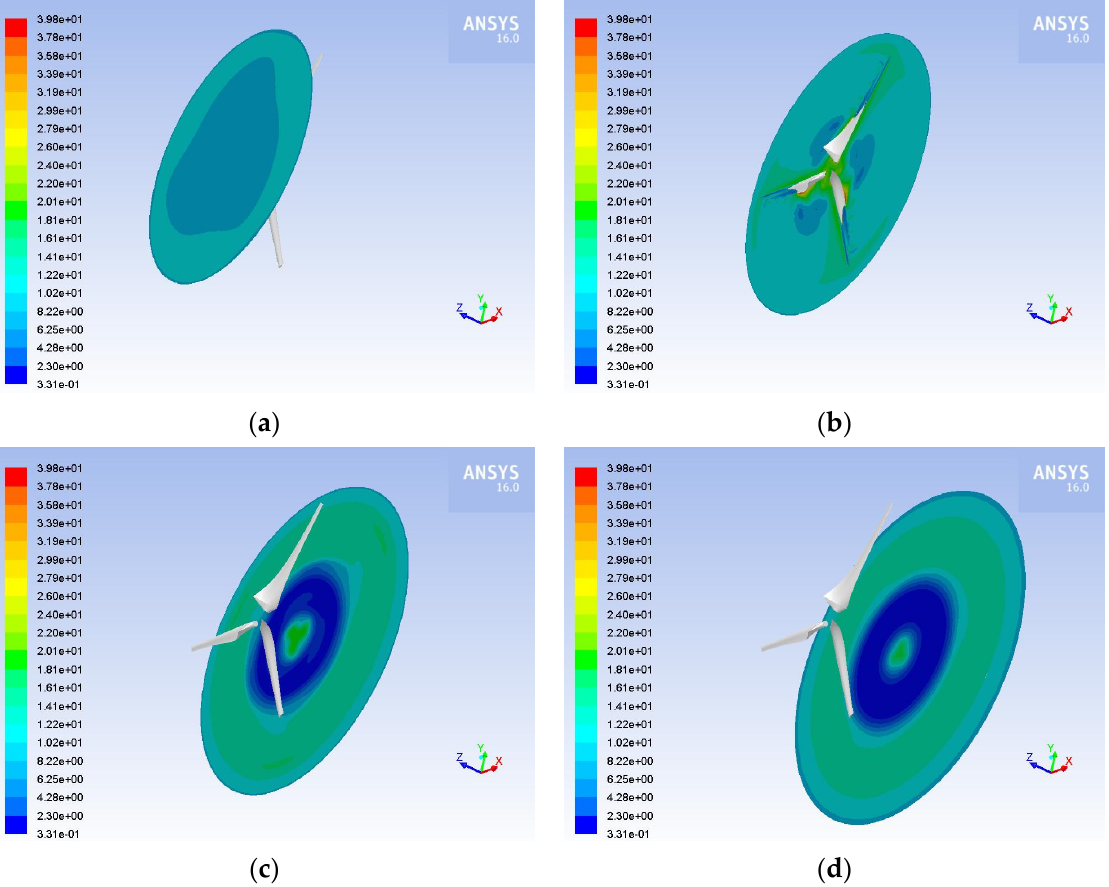
Figure 5. Contours of velocity at ( a ) − 15 m; ( b ) 0 m; ( c ) 15 m; ( d ) 30 m from the three-bladed HAWT rotor for airflow and air velocity equal to 10 m·s − 1 .